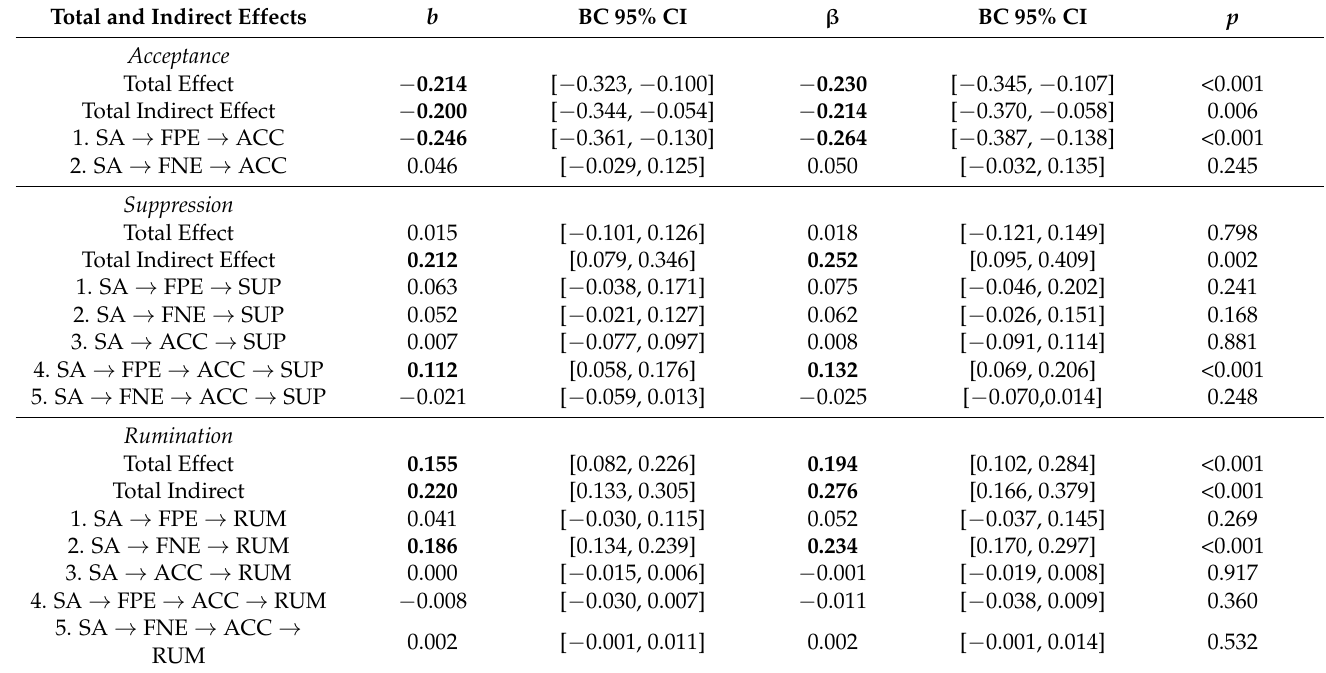
Table 5. Indirect effects of the structural equation